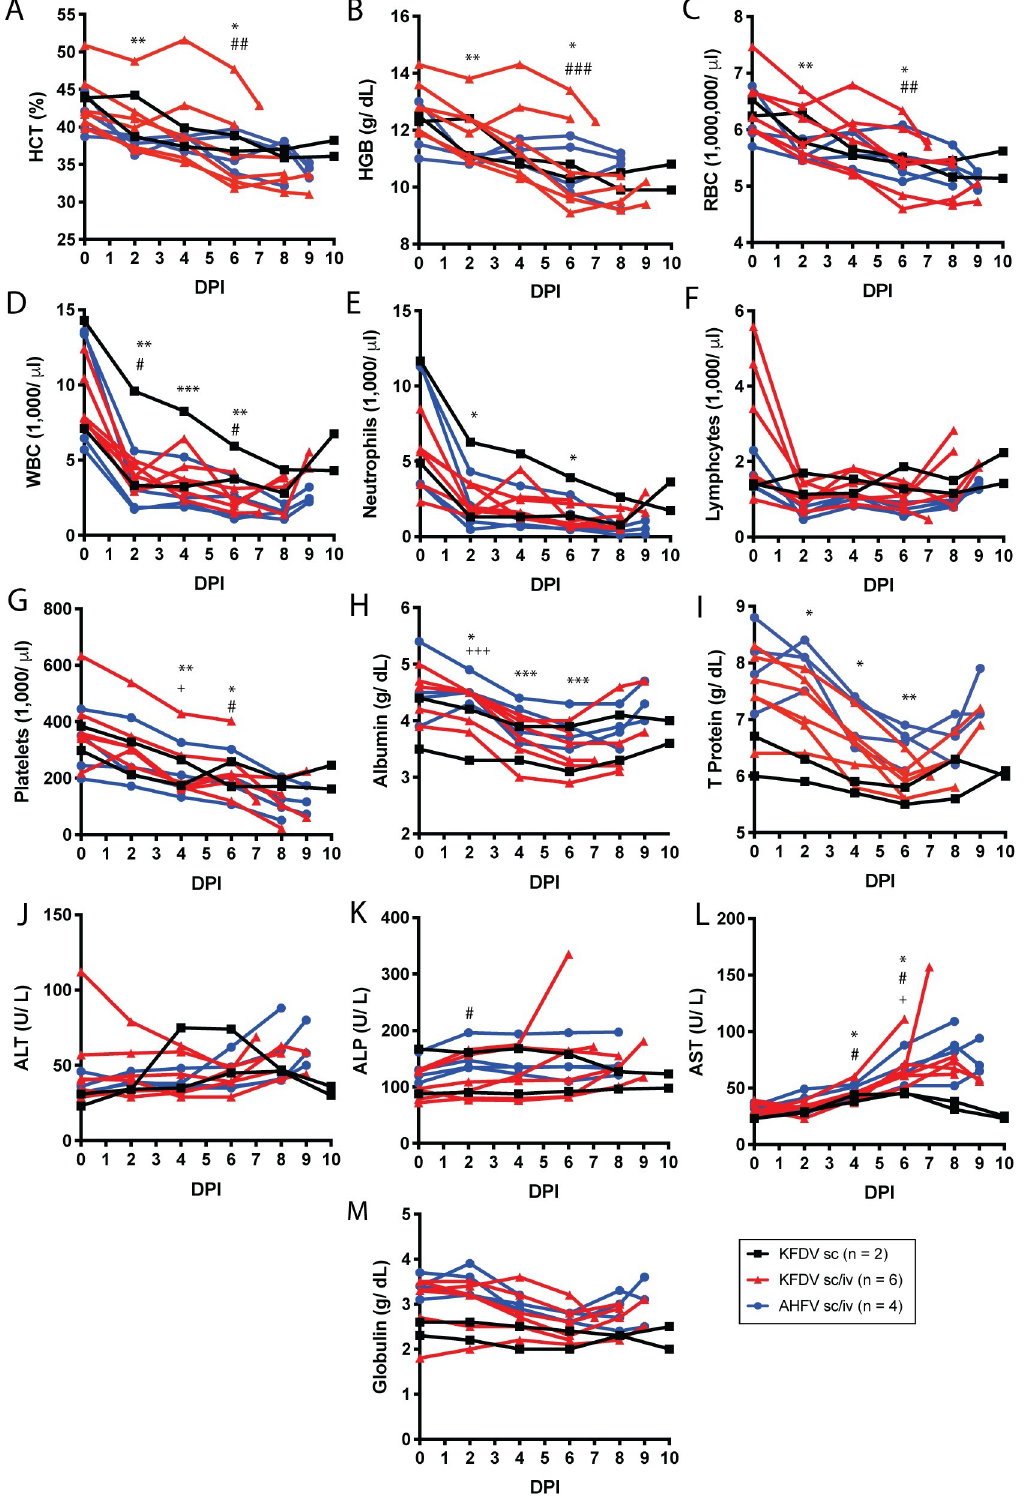
Fig 4. Blood parameters in pigtailed macaques infected with KFDV or AHFV. Blood was collected during exams as indicated. Complete blood counts were analyzed from EDTA blood (A-G), and blood chemistries were measured from